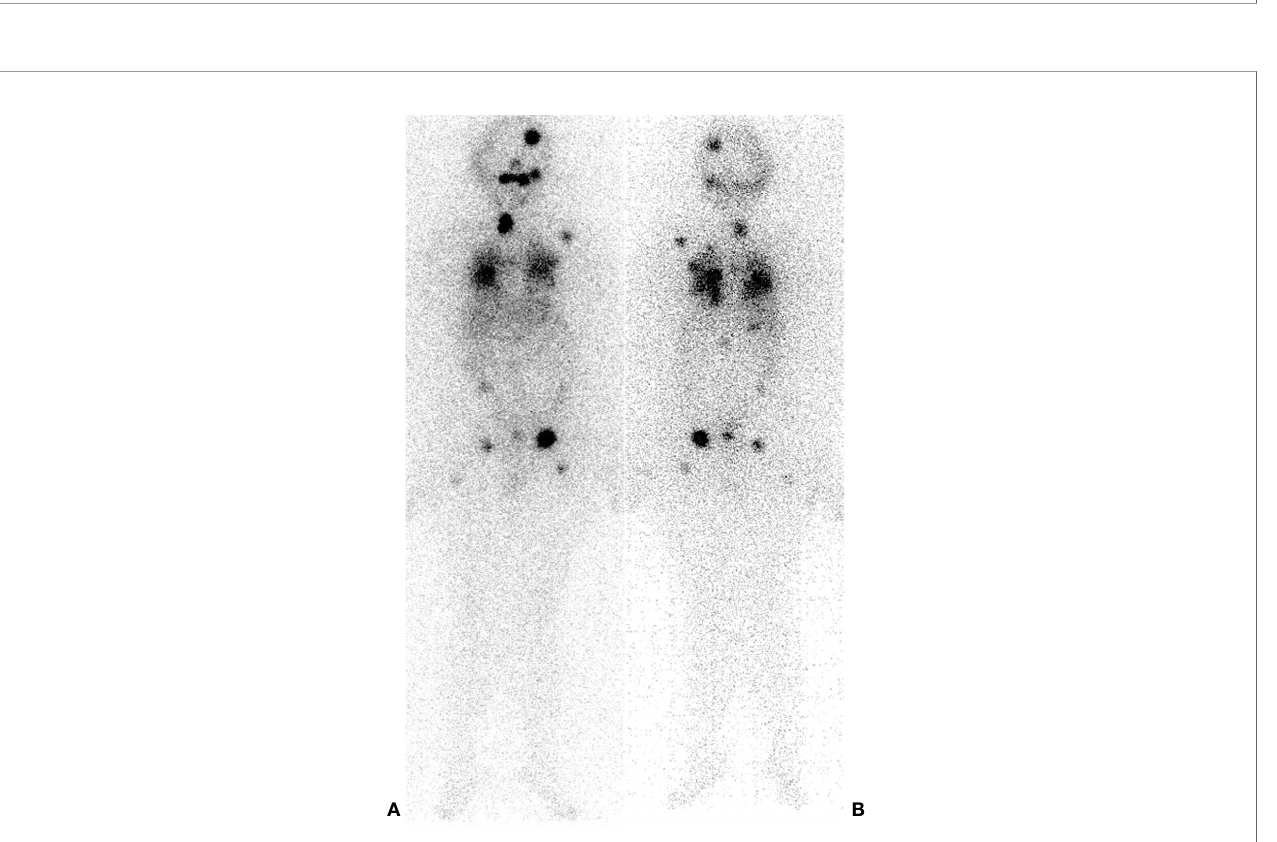
FIGURE 3 | 131 I – Post Therapy Whole Body Scan. 42 years old male, papillary thyroid carcinoma classic variant. Thyroglobulin 114. RAI cumulative dose (16650 MBq). (A) Anterior projection. (B) Posterior